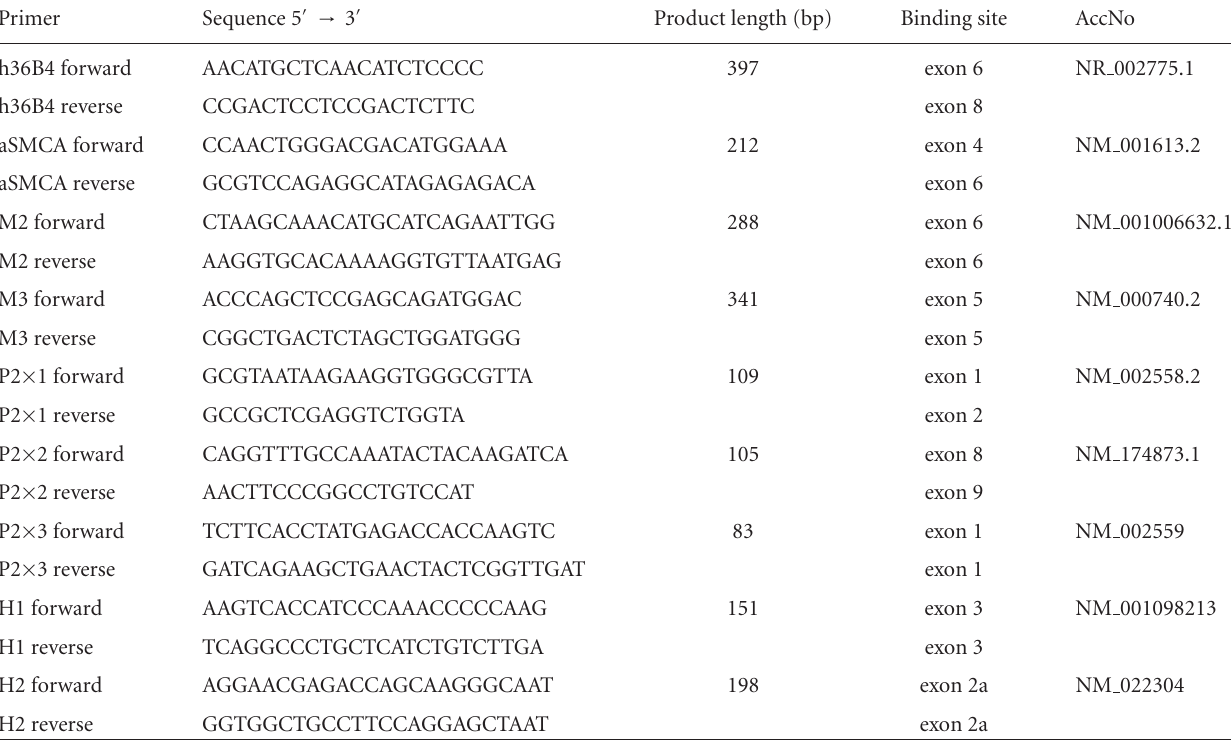
Table 2: Primers used for real-time